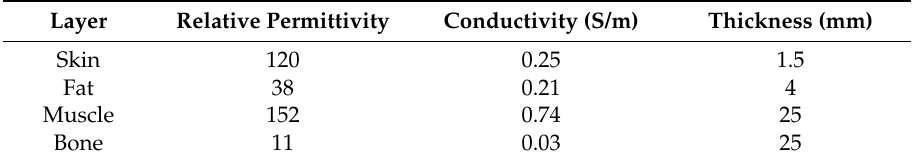
Table 3. Dielectric layers used in the simulation of the arm at 37 ◦ C.